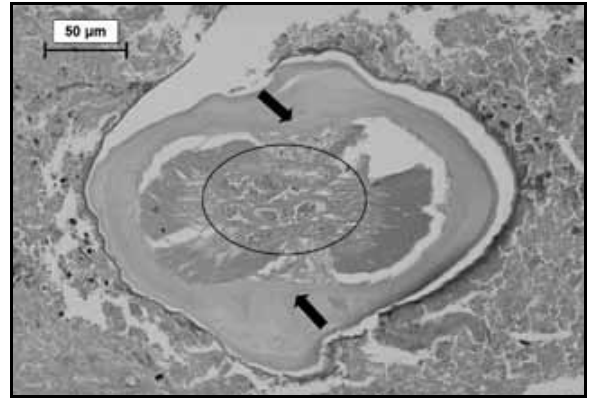
Figura 3 – Microfotografia em detalhe do parasita, envolvido por necrose, na qual se identificam as cristas longitudinais internas (setas) e órgãos internos (elipse). (PAS com diastase) PAS: ácido periódico de Schiff.